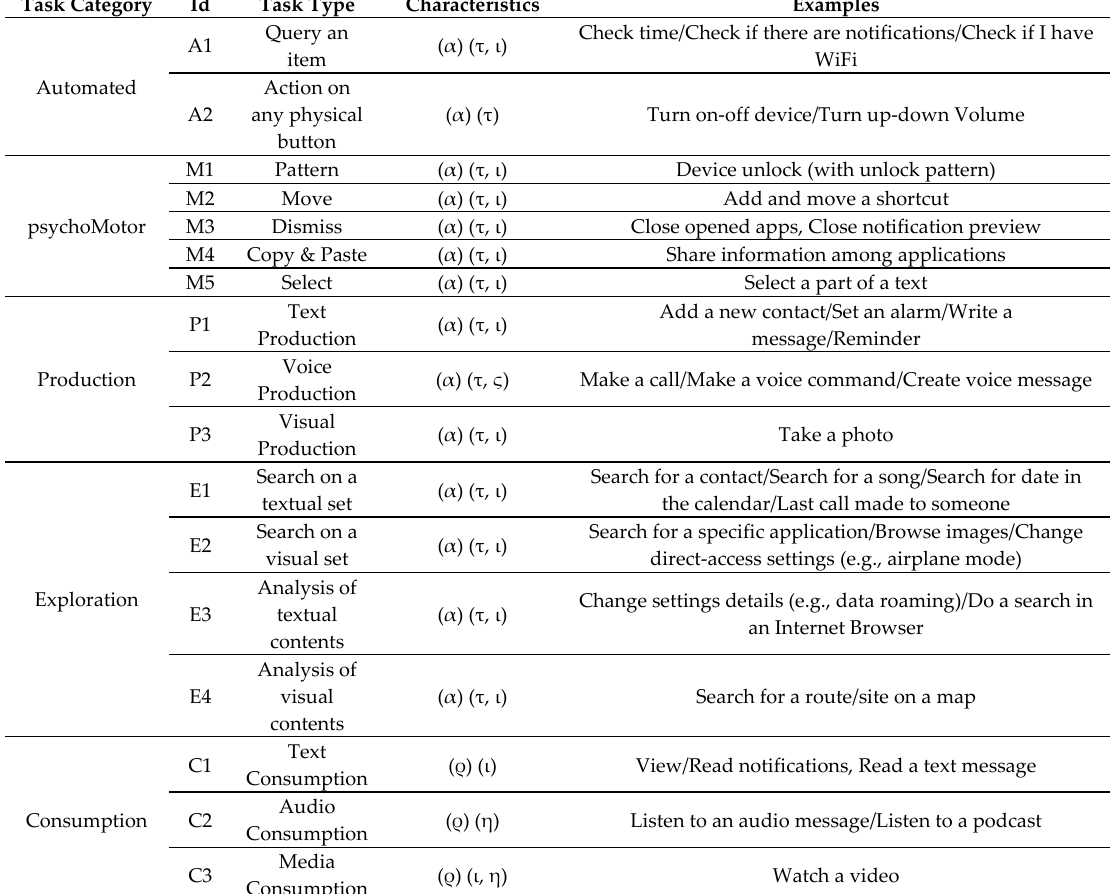
Table 1. AMPEC-10 tasks classification according to HuSBIT-10